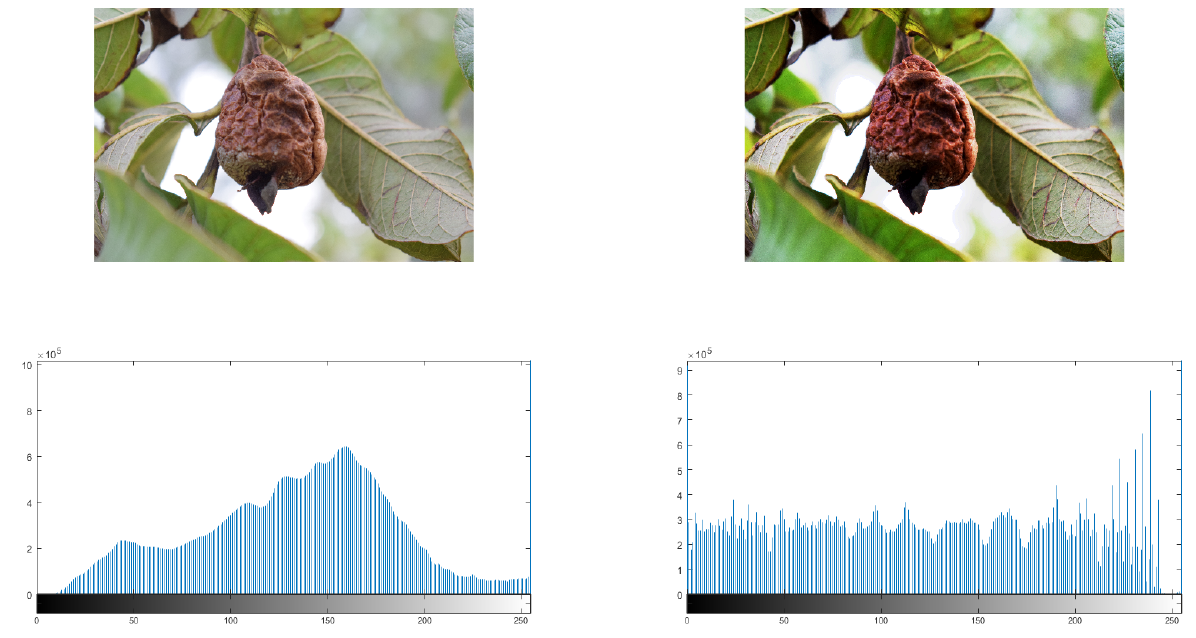
Figure 2. ( top , left ) Original and ( top , right ) enhanced. ( bottom , left ) Original and ( bottom , right ) enhanced image